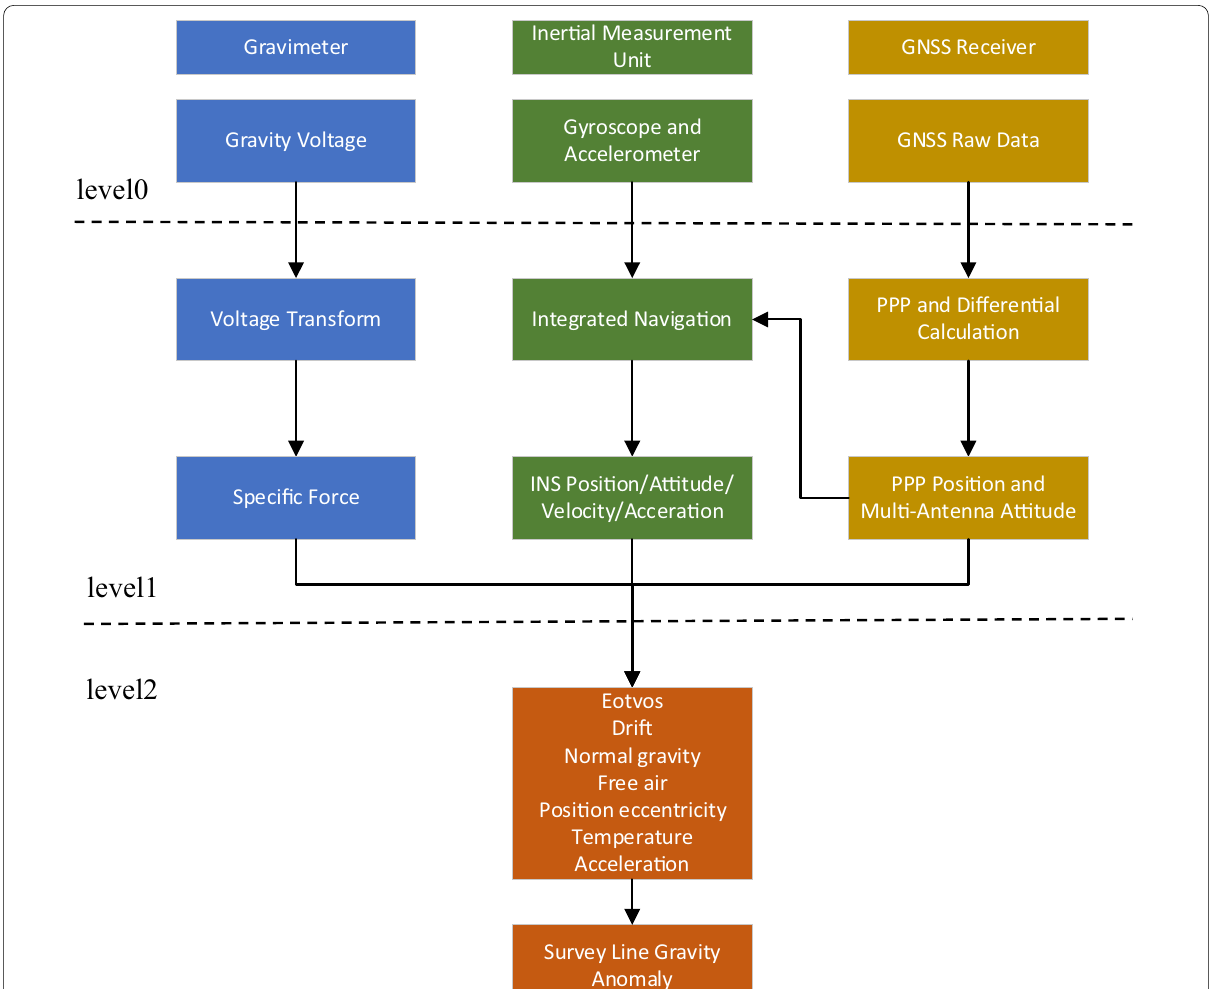
Fig. 7 Data processing flow. Level 0 contains the original instrumental observation data, level 1 contains the preprocessed data, and level 2 represents the finished product